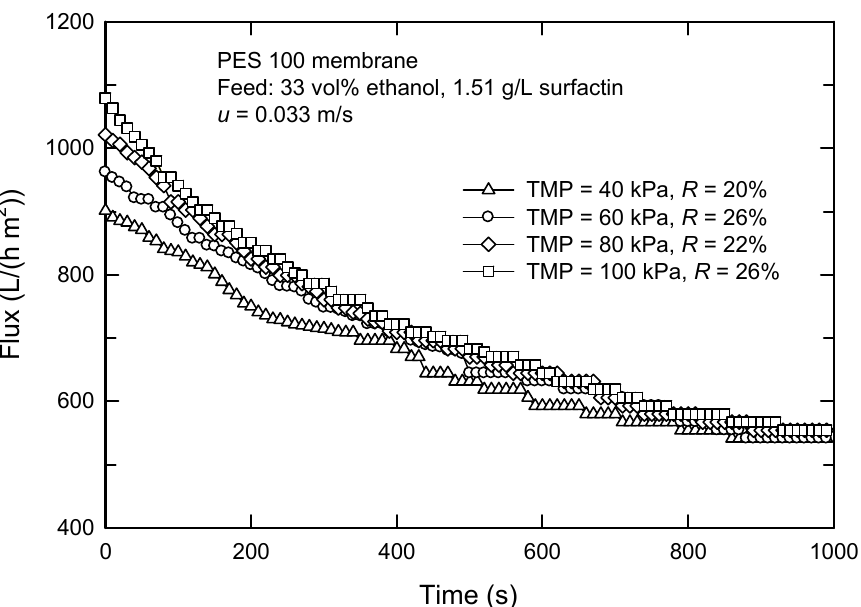
Figure 8. Effect of TMP on the flux in cross-flow UF using PES 100 membrane.